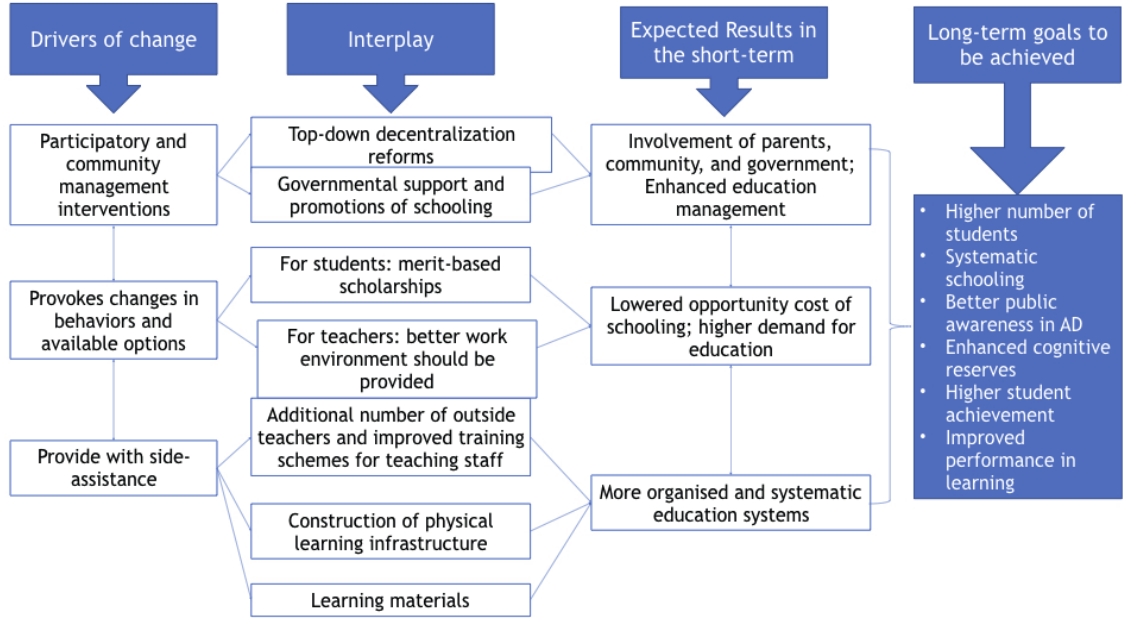
Figure 11. The three types of intervention strategies which can be applied to improve the quality of education in de- veloping communities. (Source: Niño-Zarazúa modified